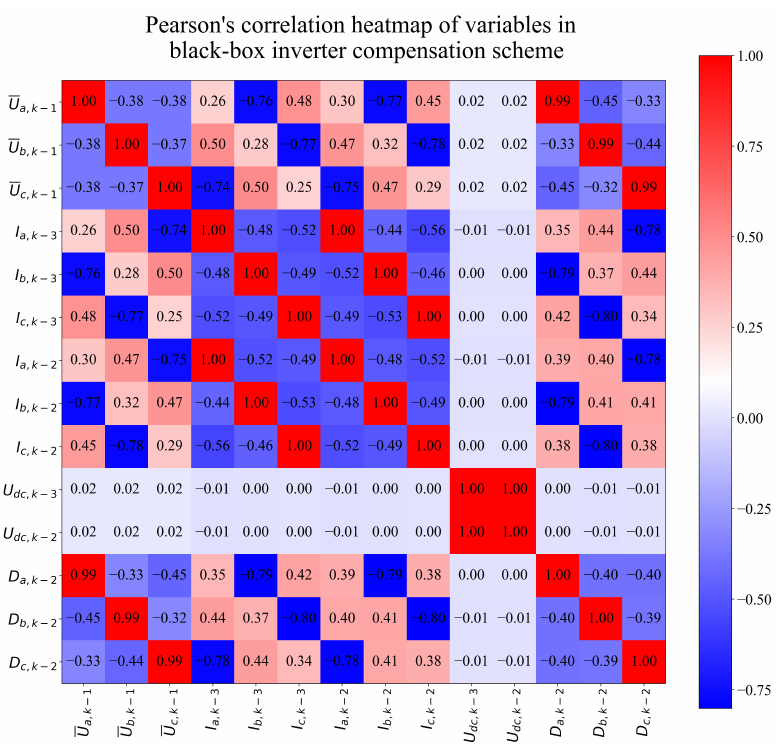
Figure A3. The Pearson’s correlation heatmap of dataset variables used in black-box compensation scheme